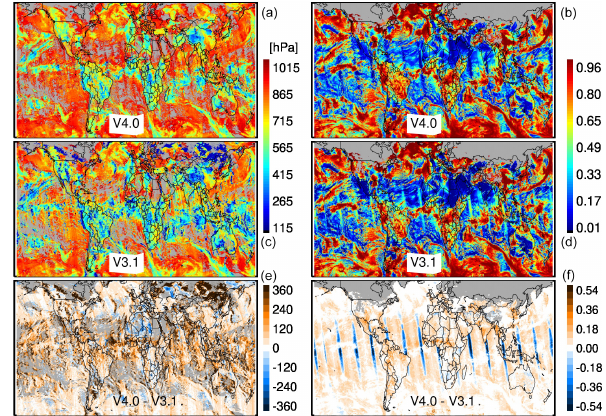
Figure 4. Cloud optical centroid pressure at 477nm (a, c, e) and cloud radiance fraction at 440nm (b, d, f) retrieved for 20 March 2005 with the OMNO2 V4.0 (a, b) and V3.1 (c, d) al- gorithms, respectively. Panels (e, f) show their differences. Gray represents the OMI pixels with retrieved cloud pressure equal to terrain pressure in V4.0 on the left and over snow and ice surface identified by the NISE flag on the